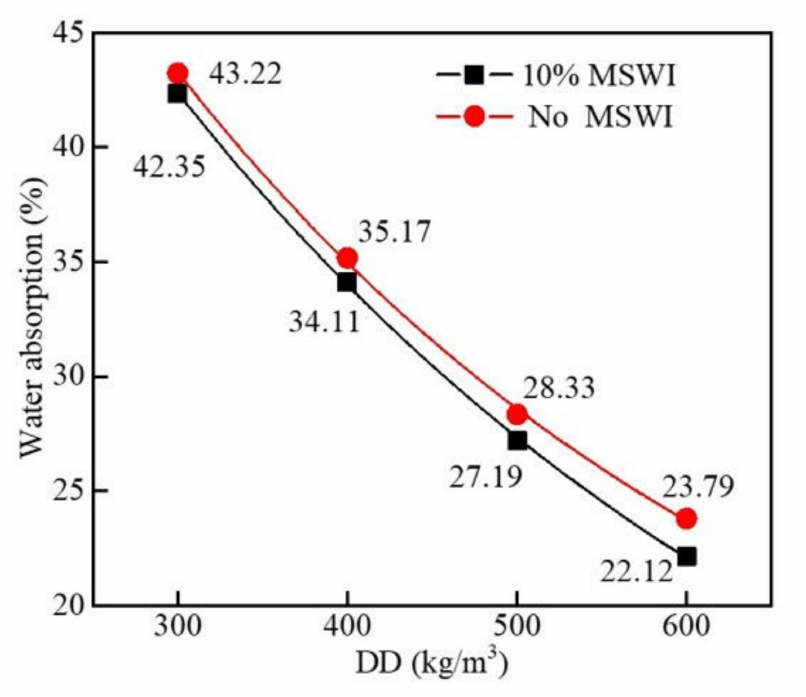
Figure 7. Water absorption of the recycled foamed concrete containing MSWI powder with different dry